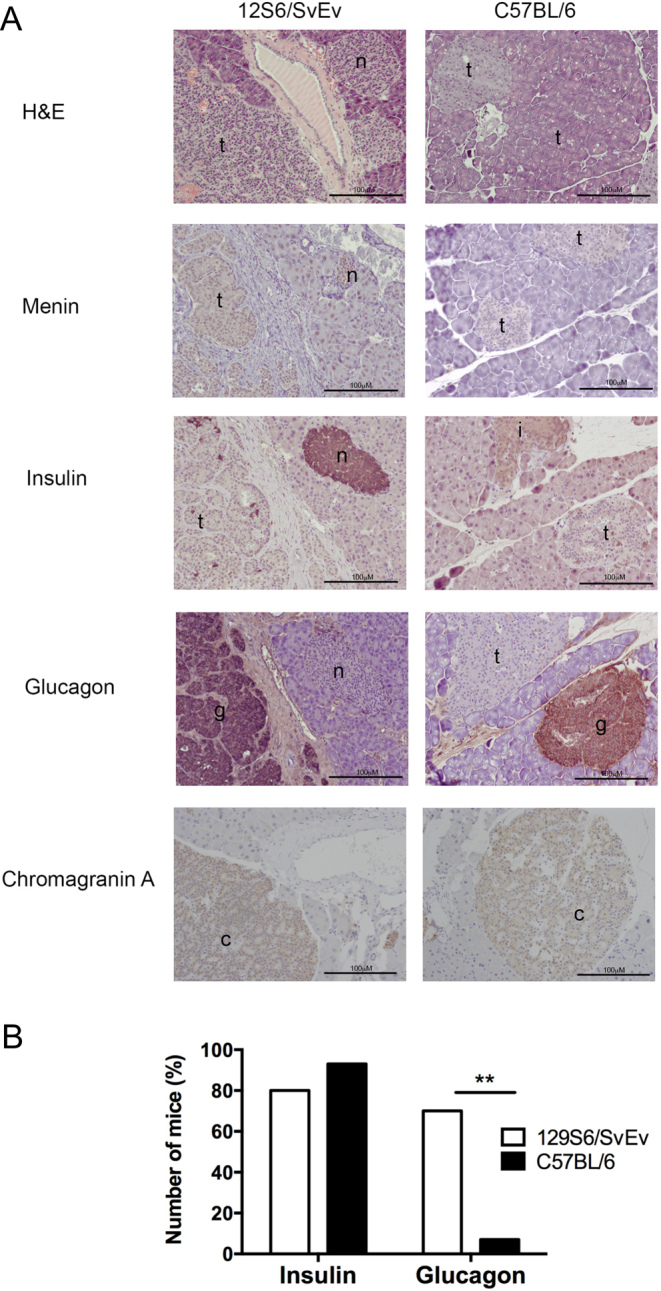
Histological and immunohistochemical analysis of PNETs in congenic Men1+/- mice. (A) Serial sections of pancreatic islet tumours from 25 ≥18-month-old Men1+/- 129S6/SvEv and C57BL/6 mice were stained with haematoxylin and eosin (H&E) and for menin, insulin, glucagon, and chromogranin A. Menin expression, indicated by brown DAB staining, was observed in normal islets (n) and normal surrounding exocrine tissue, whereas pancreatic islet adenomas showed loss of menin expression (t). Tumours with loss of menin expression (t), predominantly expressed either insulin (i) or glucagon (g). The tumours also immunostained for chromogranin A (c), confirming their neuroendocrine origin. The scale bar represents 100 μM. (B) There was no significant difference in the development of insulin-expressing PNETs between 129S6/SvEv Men1+/- mice and C57BL/6 Men1+/- mice, but a significantly greater number of 129S6/SvEv Men1+/- mice developed glucagon-expressing PNETs, when compared to C57BL/6 Men1+/- mice (**P < 0.005 using a Fishers exact test).